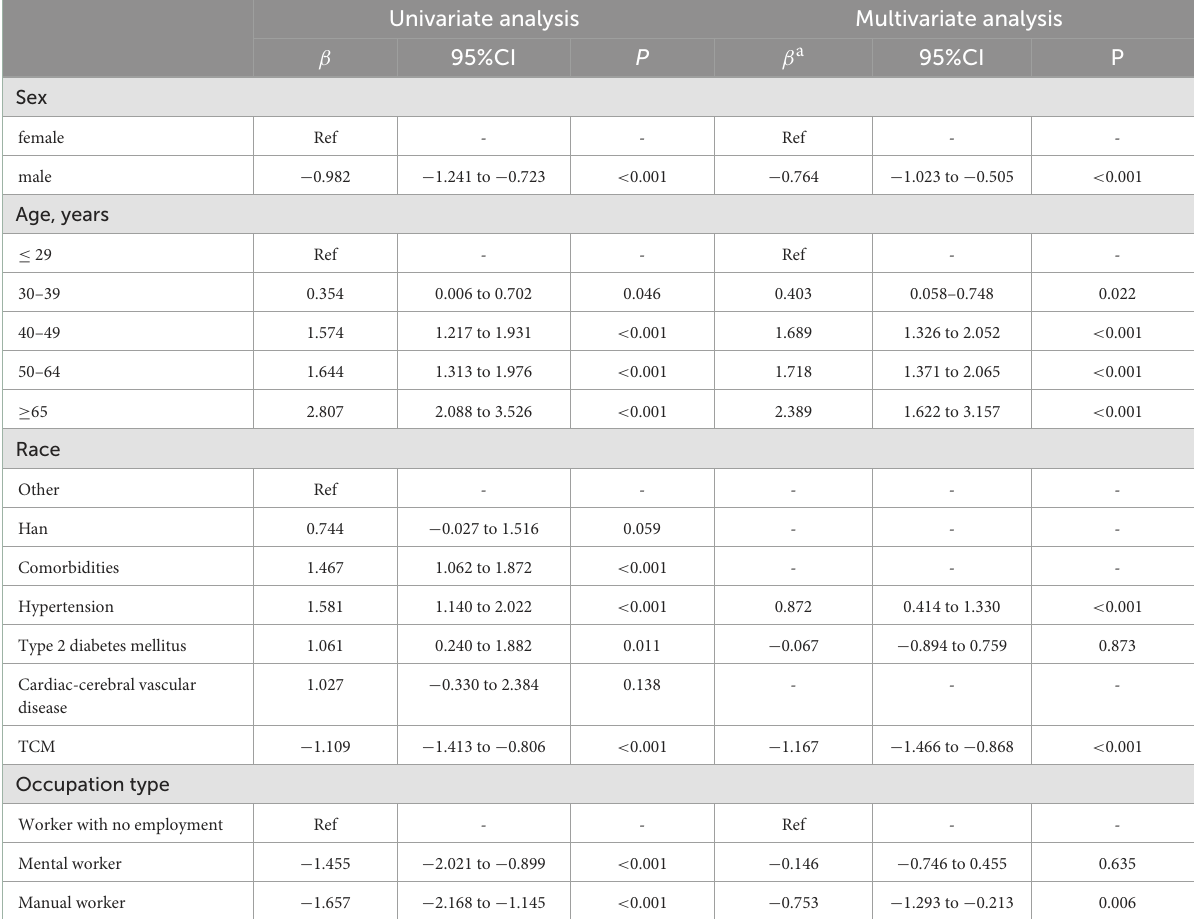
TABLE 3 Risk factors of virus clearance time among asymptomatic and mildly symptomatic